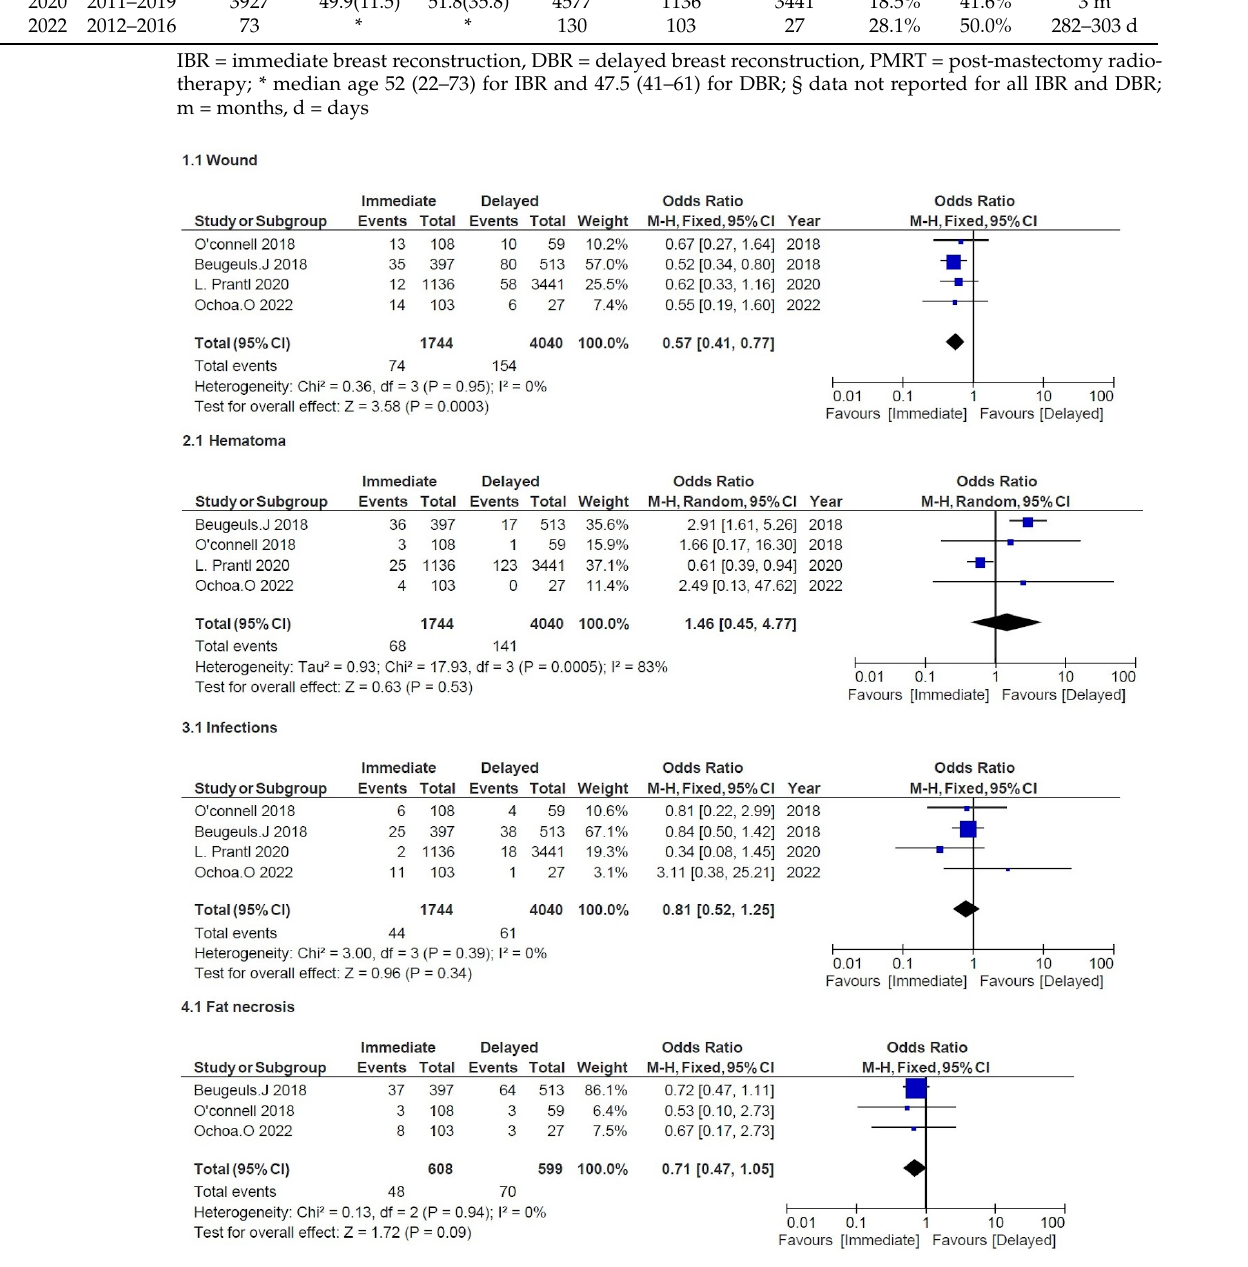
Figure 3. Combined ORs to assess effect of immediate versus delayed DIEP on adverse events for minor complication: ( 1.1 ) wound healing, ( 2.1 ) hematoma, ( 3.1 ) infections, and ( 4.1 ) fat necrosis [8,9,14,19]. Blue shapes correspond to individual studies. Squares size is proportional to the weight of the study while black diamonds shapes correspond to pooled studies.